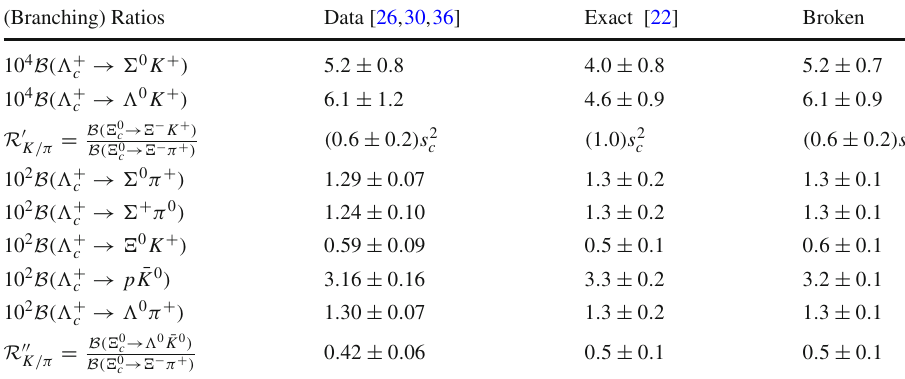
Table 2 The data of the B c → B n M decays, together with the reproduction with the exact (broken) SU ( 3 ) f symmetry in the 3rd (4th) column